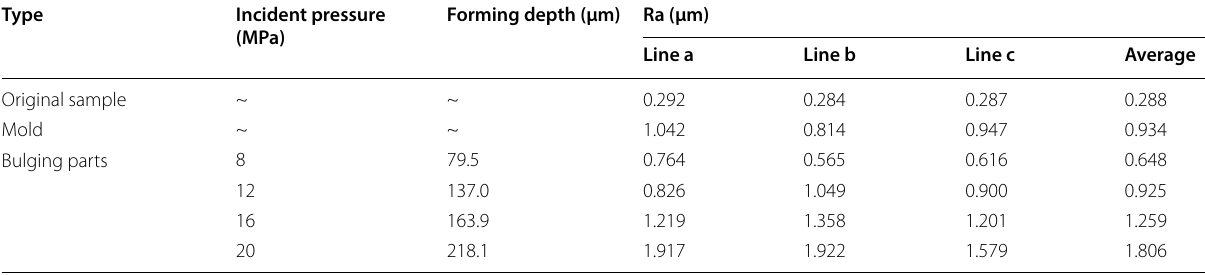
Table 4 Summary of roughness measurement